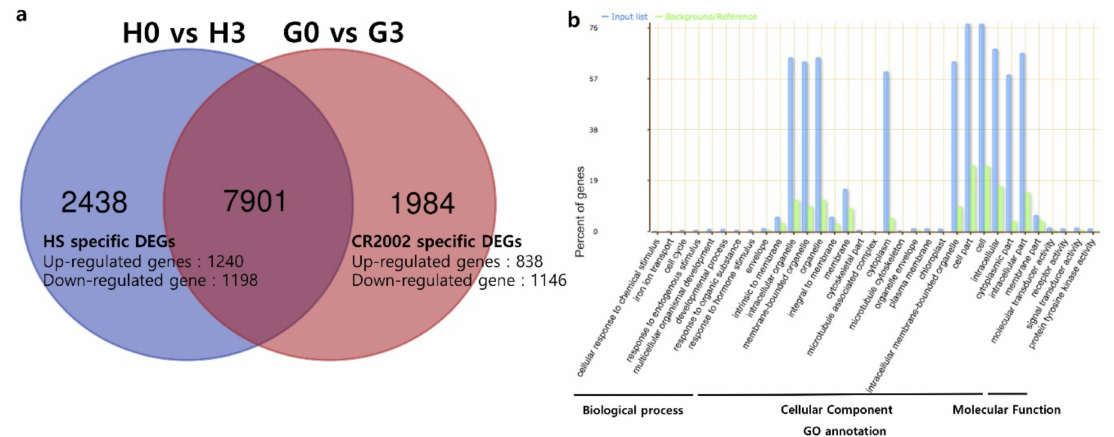
Figure 8. Summary of the numbers of di ff erentially expressed genes (DEGs) upon incubation of leaves of two lines (Hwaseong and CR2002) in complete darkness. ( a ) A Venn diagram, showing the number of genes shared and distinct to each genotype. ( b ) Significantly enriched gene ontology (GO) terms for CR2002-specific DEGs. Blue and green bars indicate the input list of CR2002 and background / reference, respectively. H0, H3, G0, and G3 indicate Hwaseong day 0, Hwaseong day 3, CR2002 day 0, and CR2002 day 3 in dark condition,